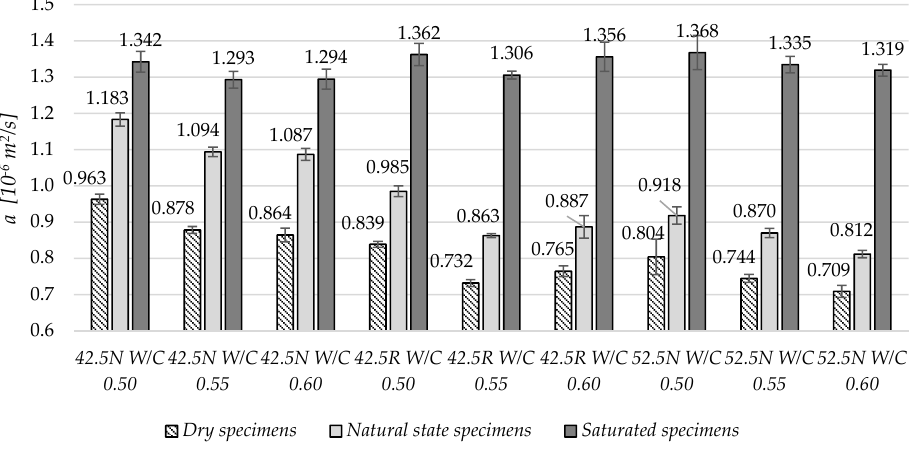
Figure 7. The average thermal diffusivity values in three moisture states.